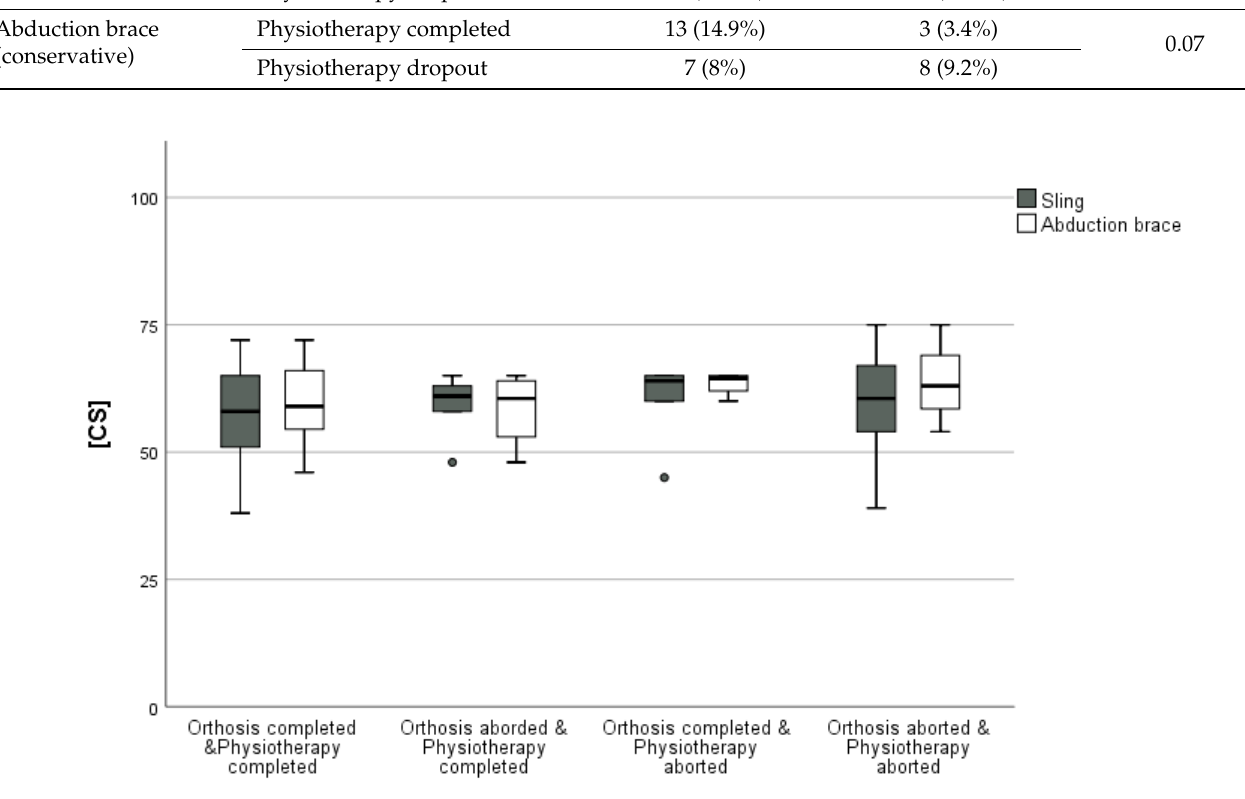
Figure 1. Boxplot of the CS [points] according to compliance collectives. A total of n = 66 (44.3%) participants dropped physiotherapy: n = 30 (45.5%) for COVID-19 pandemic reasons, n = 25 (37.9%) for other scheduling issues, and n = 11 (16.7%) no longer considered physiotherapy necessary Table 3. Distribution of the CS according to compliance collectives. A total of n = 10 patients had a complication, either with varus dislocation of the humeral head or dislocation of the greater tuberosity. The distribution within the evaluated groups is shown in Table 4. Moreover, other complications were detected: n = 3 (2%) patients suffered from resorption of the greater tuberosity, n = 2 (1.3%) cases of avascular necrosis were detected, and n = 1 (0.6%) patient developed pseudoparalysis. In n = 1 (0.6%) case of 45 ◦ varus dislocation as well as in n = 1 (0.6%) case of avascular necrosis, an indication for surgical revision was discussed but declined by the